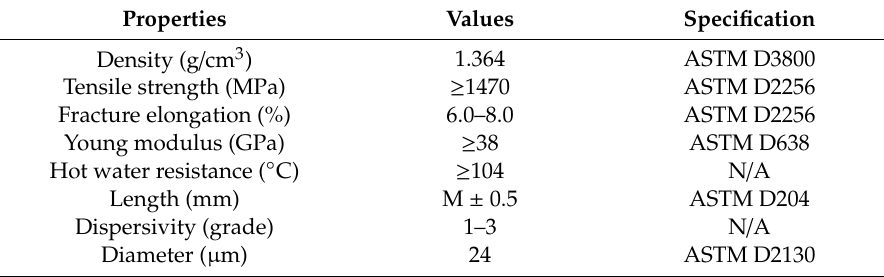
Table 3. Properties of polyester fiber (provided by manufacturers).